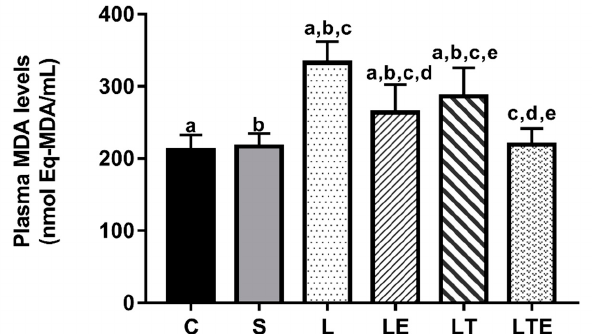
Figure 4. Plasma malondialdehyde (MDA) analysis. Plasma malondialdehyde (MDA) levels (nmol eqMDA / mL) after interventions in the di ff erent groups: C, control group; S, sham group; L, injury group; LE, injury + extract group; LT, injury + training group; LTE, injury + training + extract group. Values are expressed as mean ± standard deviation ( n = 10 in each group). The letters “a”, “b”, “c”, “d” and “e” when repeated indicate statistical di ff erences between the groups as determined by one-way ANOVA with Bonferroni post-hoc